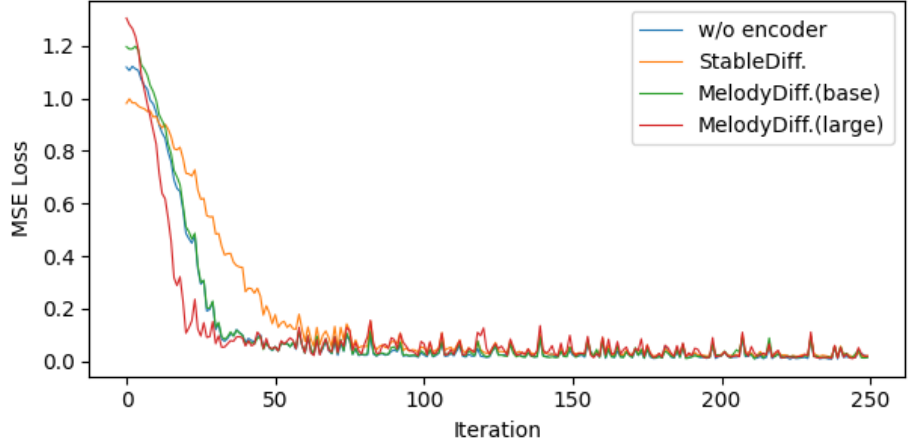
Figure 6. Change in MSE loss during training.